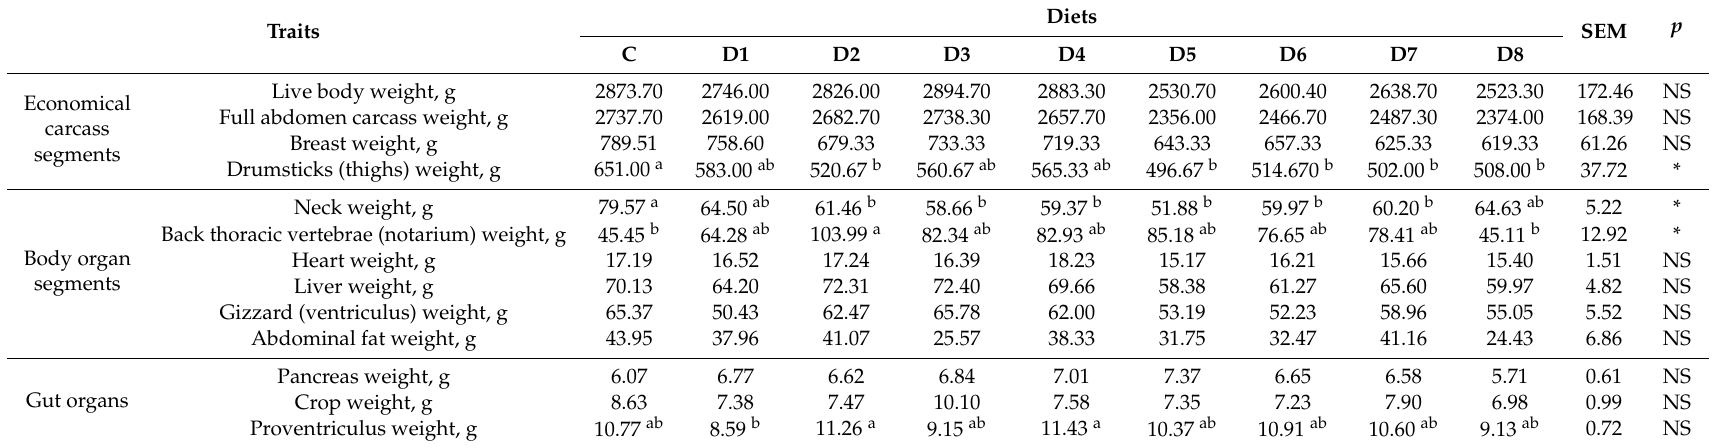
Table 4. Economical carcass segment means of Ross 308 broilers fed diets containing di ff erent levels of L-carnitine, lysine, and methionine from day 1 to day 42 of